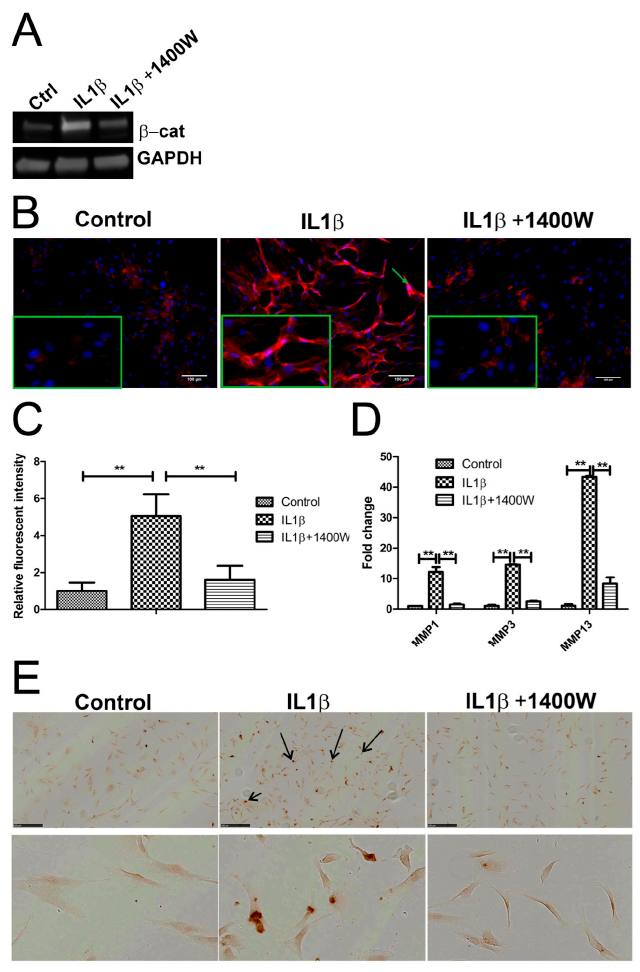
Figure 6. Blocking iNOS decreased β -catenin, matrix metalloproteinases (MMPs) expression, and inhibited apoptosis. ( A , B ) Chondrocytes were treated with 10 ng/mL recombinant human IL-1 β or 100 uM iNOS inhibitor 1400W for 24 h. The protein expression of β -catenin was detected by Western blot and IF, green arrow indicated nuclear positive staining of β -catenin, magnified pictures were indicated in inserts. ( C ) Quantification of immunofluorescence intensity was performed by CellProfiler software. ( D ) MMP mRNA expression was measured by qPCR. ( E ) Apoptosis of human chondrocytes was detected using the DeadEnd colorimetric TUNEL assay. Apoptotic nuclei were stained dark brown (dark arrow). Images were taken using Hamamatsu Nanozoomer. Scale bar = 250 µ m, top panel indicate overview of cell apoptosis, below panel indicates enlarged picture. * p < 0.05, ** p < 0.01: significant correlation.